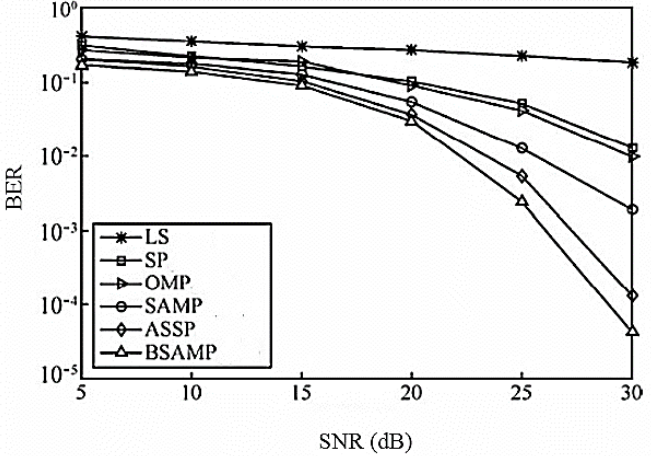
Figure 2. Bit error rate (BER) comparison of each algorithm under different SNRs.